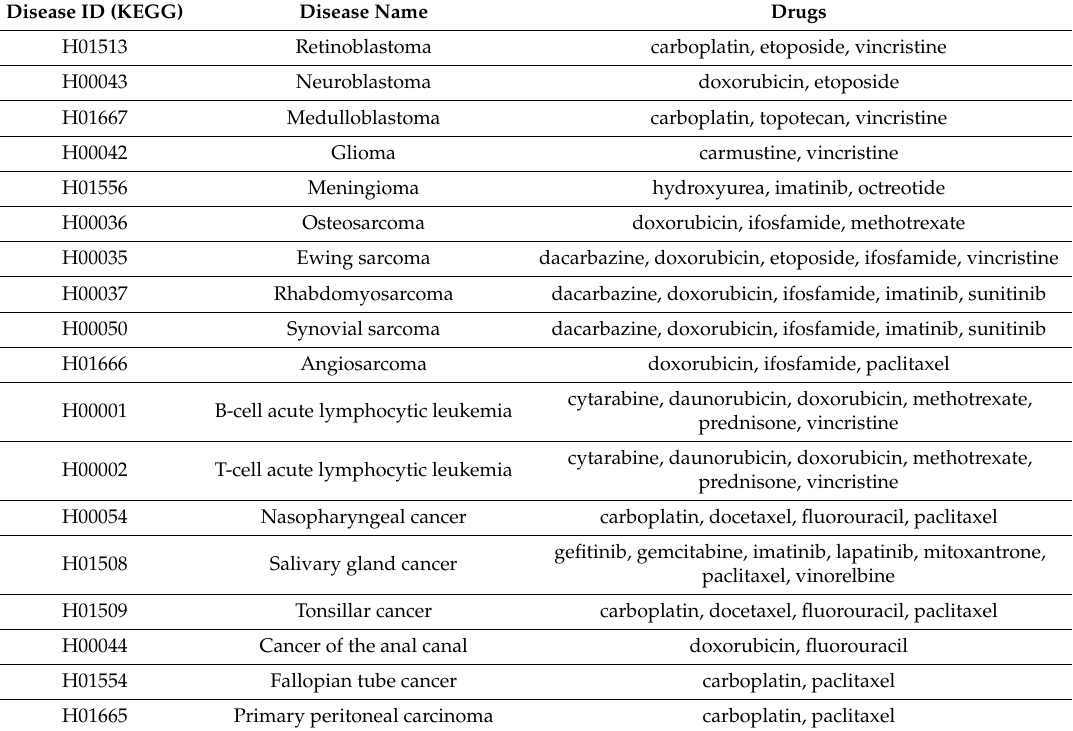
Table 1. Diseases clustered close to IBC and their corresponding drugs.